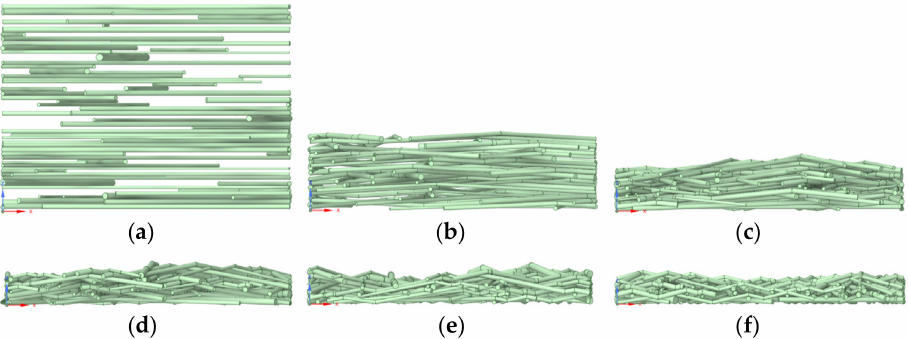
Figure 8. Profile view of fiber geometry with varied maximum slope. ( a ) Straight fibers (0% slope). ( b ) 5% Slope. ( c ) 10% Slope. ( d ) 15% Slope. ( e ) 20% Slope. ( f ) 25% Slope.